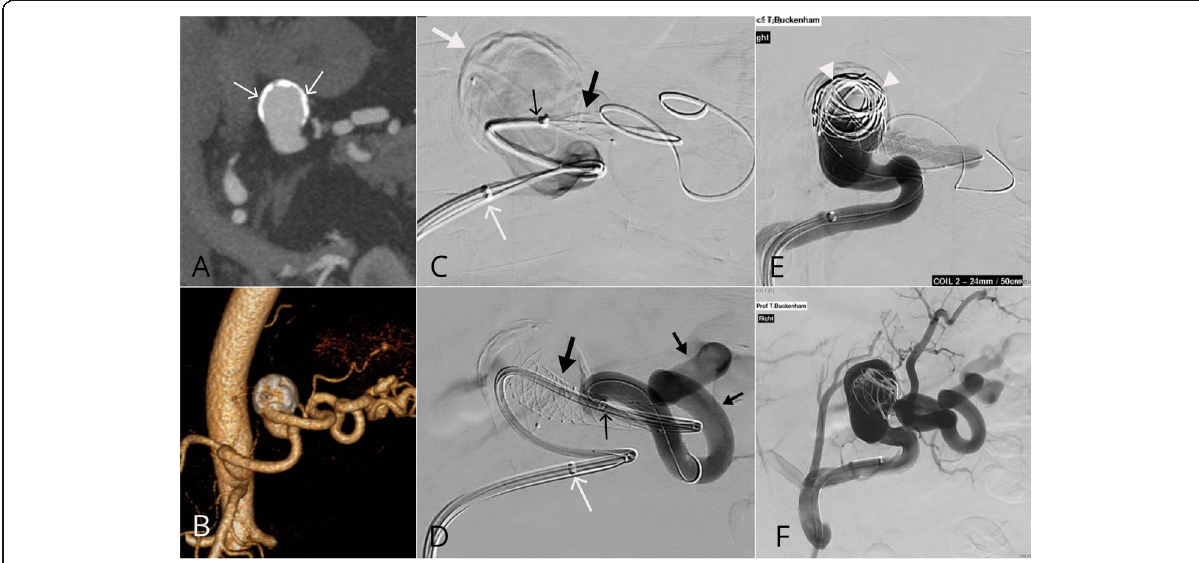
Fig. 1 Large wide necked splenic artery aneurysm. a and b An incidentally detected 39 mm partially calcified wide (white arrows) necked (14 mm) splenic aneurysm was seen to arise from the midportion of a tortuous splenic artery. c after difficulty obtained stable access using a 6Fr NeuronMAX 088 guide sheath (thin white arrow) the aneurysm was accessed with a Headway Duo microcatheter and the CASPER stent (thick black arrow) deployed over an 0.014in. microwire. The marker of the CASPER deployment system (thin black arrow) can be seen during unsheathing of the stent. d The 6Fr NeuronMAX 088 guide sheath remained stable in position (thin white arrow) after CASPER stent deployment (thick black arrow). A 5Fr Sofia intermediate catheter was used to navigate through the stent. An angiogram performed via the 5Fr Sofia demonstrates patency of the distal splenic artery (small black arrows). e 24 mm coils were subsequently loosely packed into the aneurysm to promote thrombosis (white arrow heads). f The final angiogram demonstrates patency of the stent and distal splenic artery and its branches